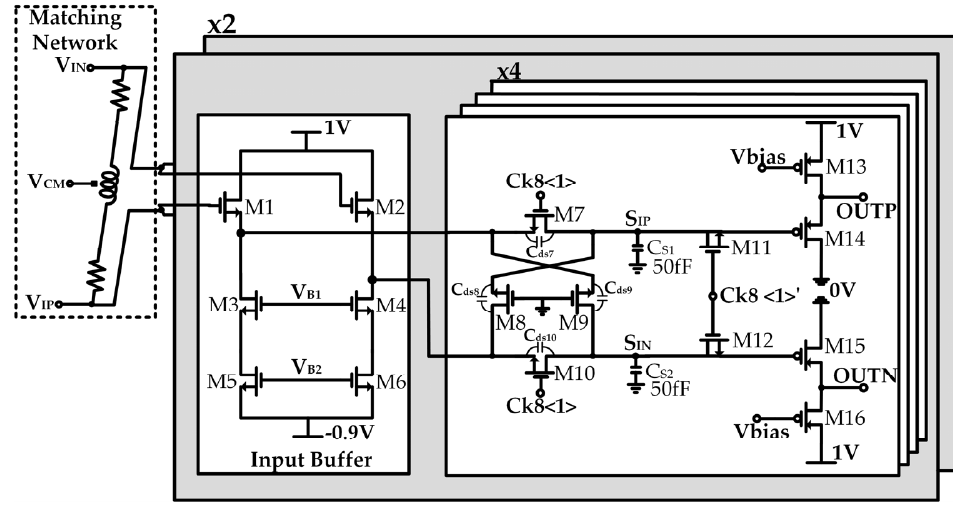
Figure 2. The ADC sampling front-end.